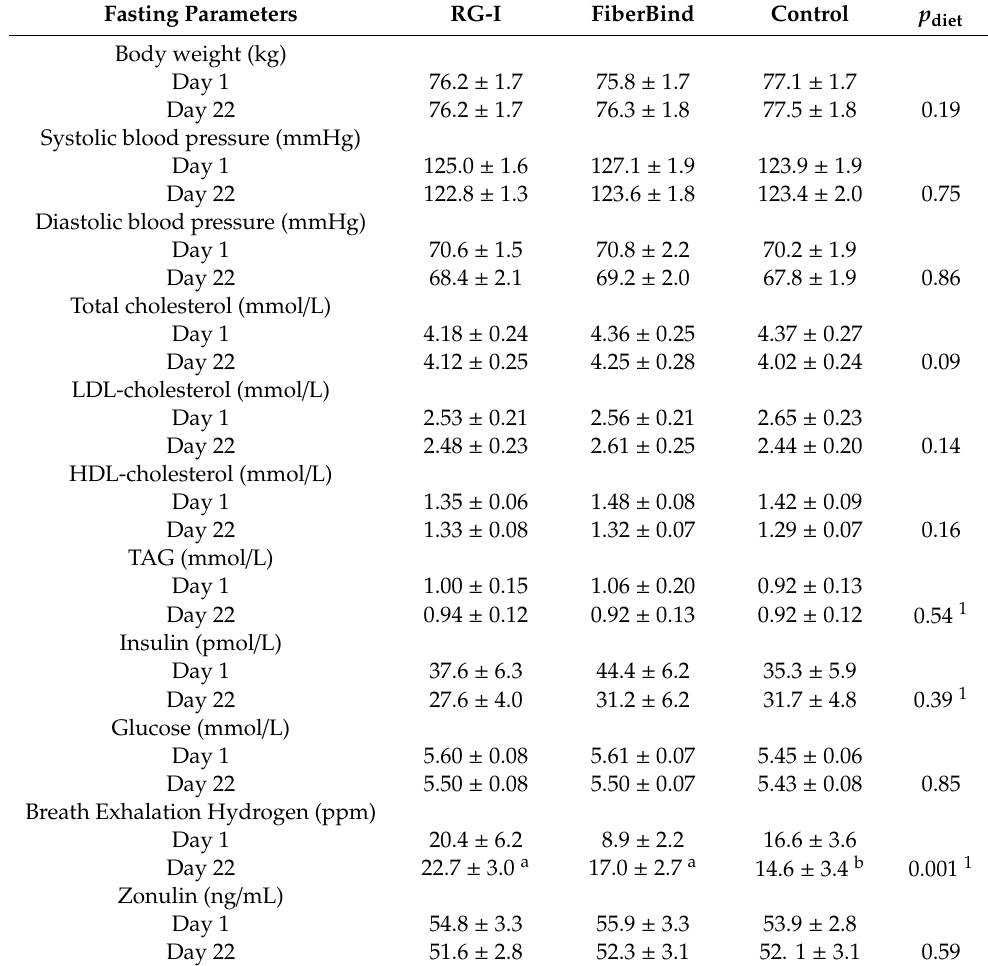
Table 5. Fasting parameters on Days 1 and 22 of the three intervention